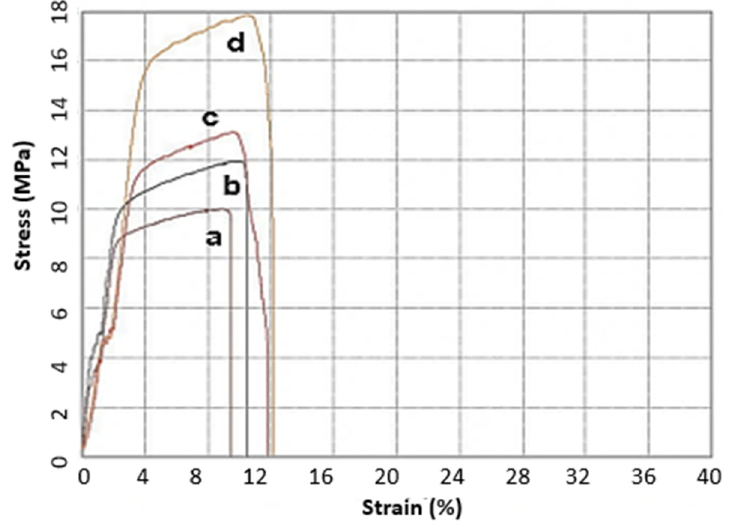
Figure 3. Mechanical properties of (a) pure-F1, (b) nCeO 2- F2, (c) nCeO 2- F3 and (d) nCeO 2-